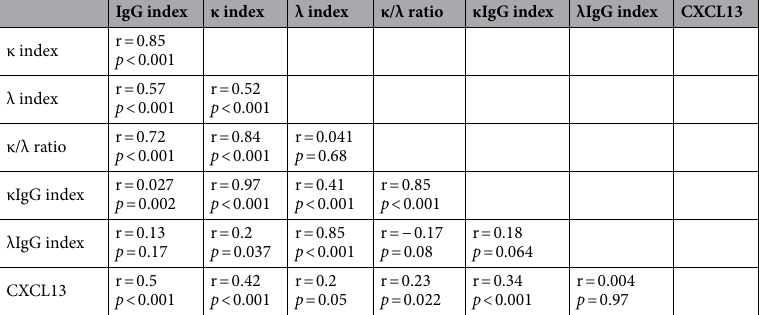
Table 5. Spearman’s correlations between the different CSF variables related to the humoral immune response in the total study population (n =